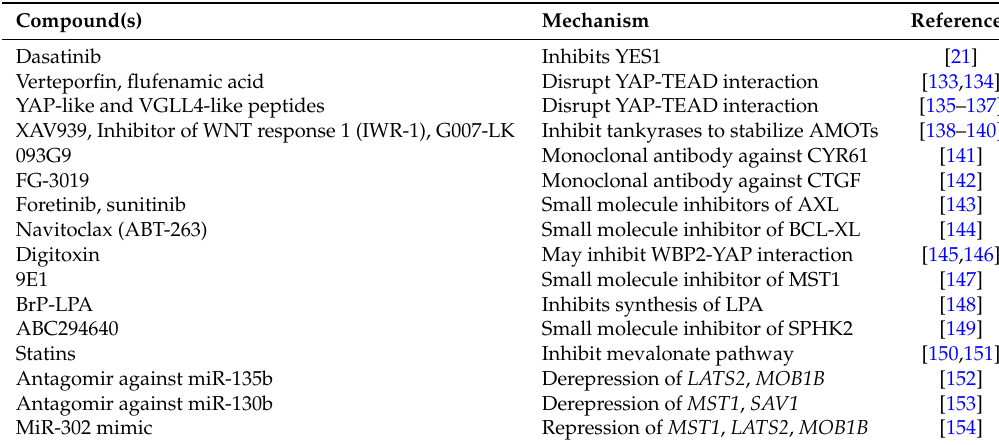
Table 1. Therapeutic approaches to regulate YAP/TAZ